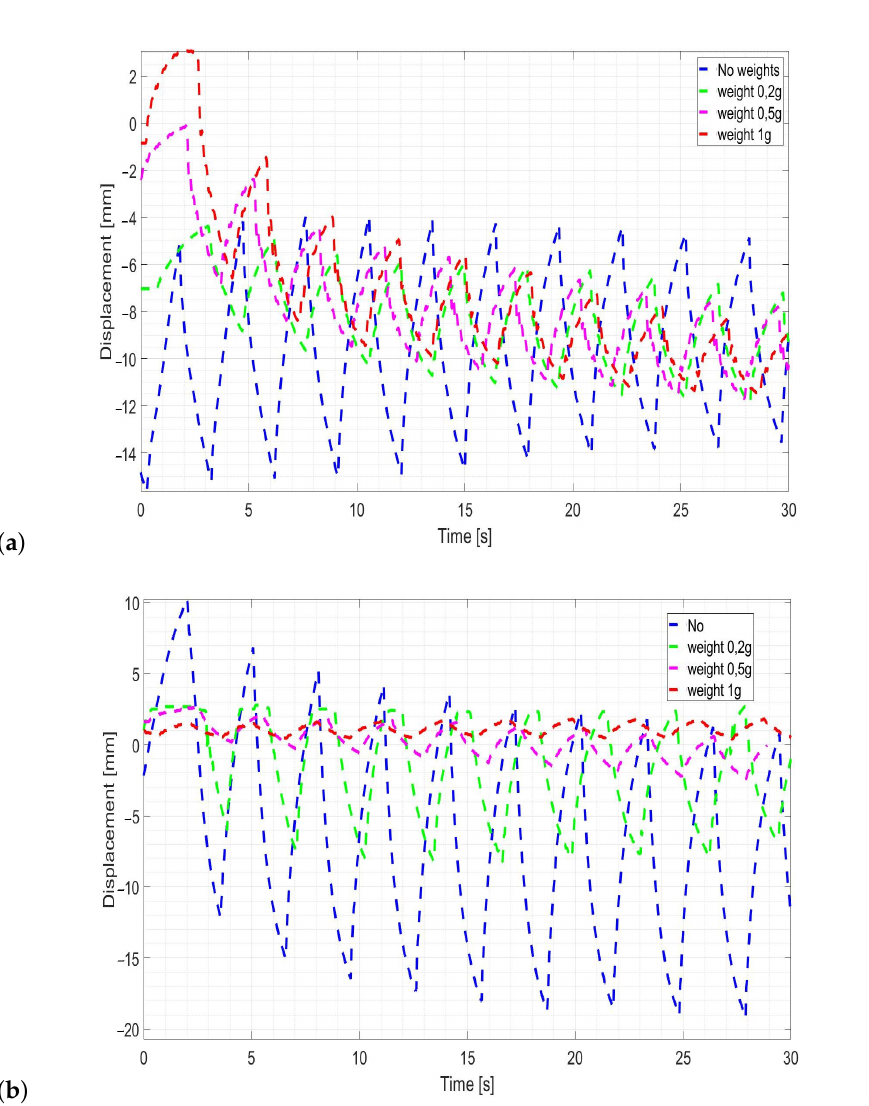
Figure 7. Displacement values of electroactive sample 1 under load ( a ) and electroactive sample 2 ( b ). For the strip sample 2, very good measurement results were obtained for a load of 0.2